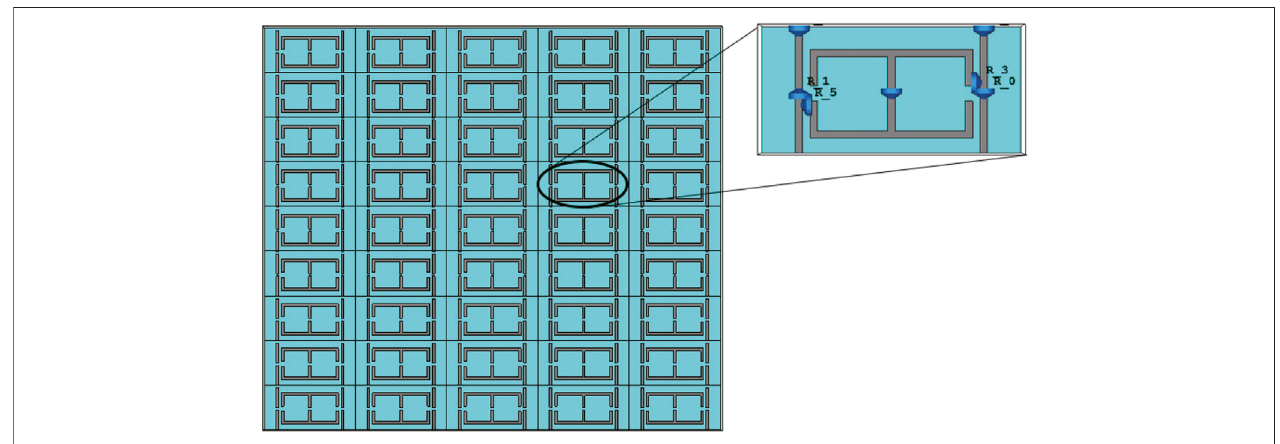
FIGURE 2 | Schematic of the recon fi gurable metasurface with a periodic structure.